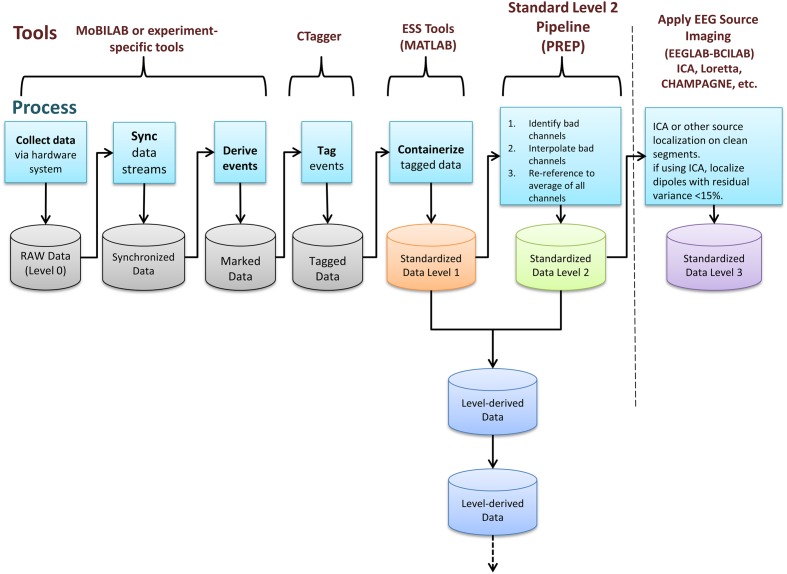
EEG Study Schema (ESS) processing stages and tools used to transform data into successive containerized ESS standard level formats (Delorme and Makeig, 2004; Kothe and Makeig, 2013).